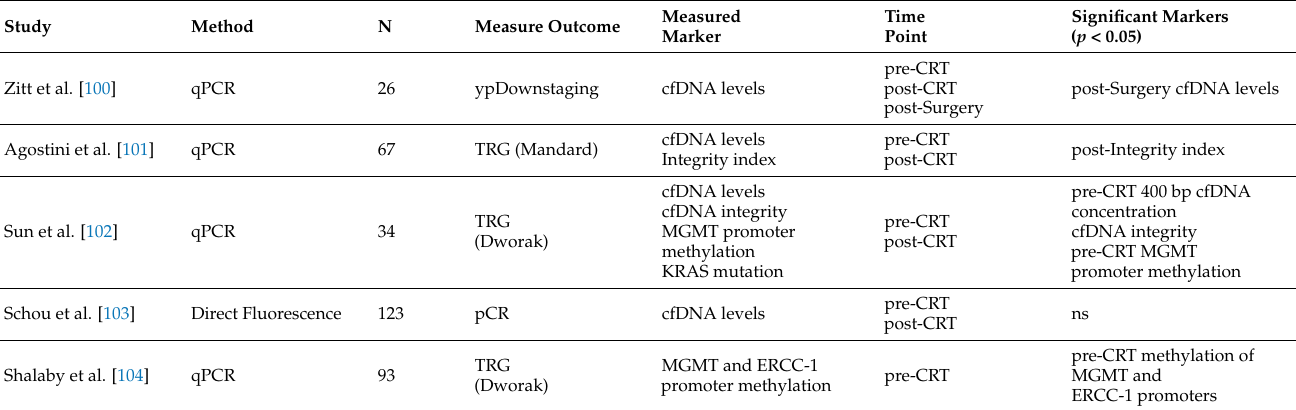
Table 3. Studies exploring cfDNA as a biomarker predictive of tumor regression following